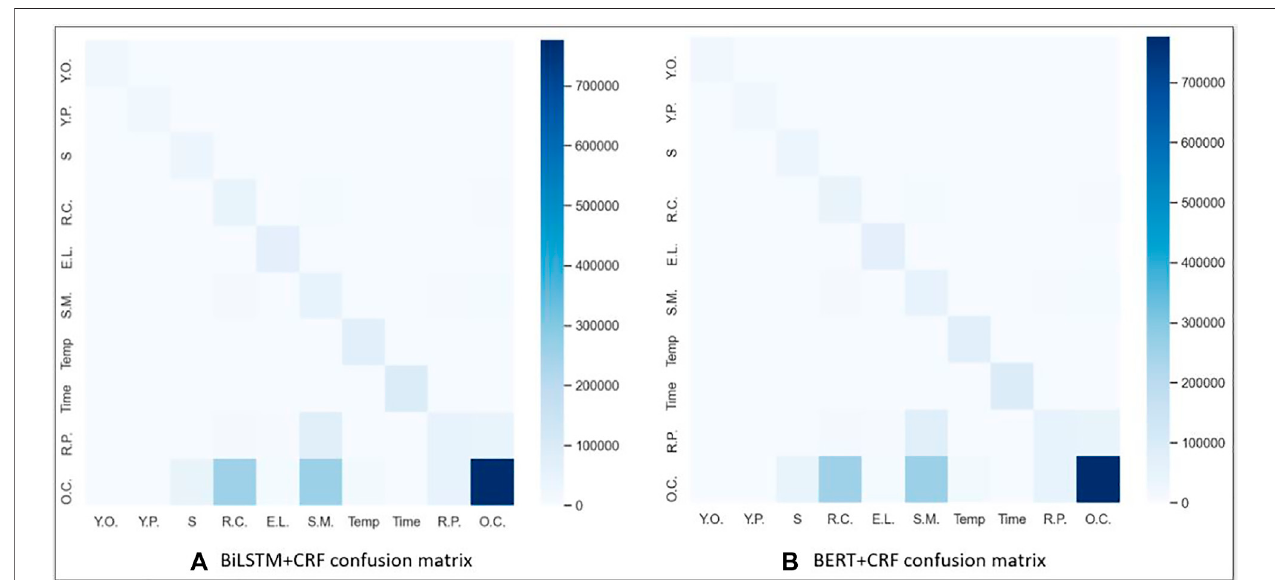
FIGURE 2 | Confusion matrix using (A) BiLSTM + CRF and (B) BERT + CRF results. Keys for the acronyms are as follows: EXAMPLE_LABEL (E.L.), REACTION_PRODUCT (R.P.), STARTING_MATERIAL (S.M.), REAGENT_CATALYST (R.C.), SOLVENT (S), OTHER_COMPOUND (O.C.), YIELD_PERCENT (Y.P.), YIELD_OTHER (Y.O.), TIME (Time), and TEMPERATURE (Temp).